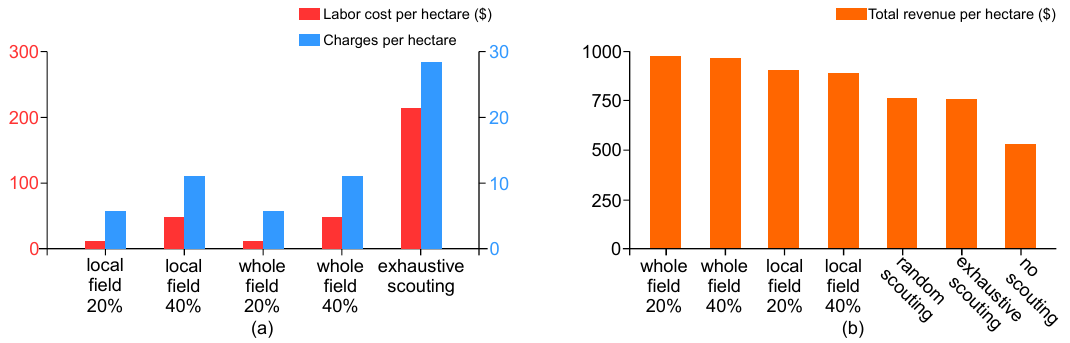
Figure 9. ( a ) Energy implementations and labor costs of autonomous scouting vs. exhaustive scouting; and ( b ) the impacts that autonomous scouting have on revenue compared to state of the practice